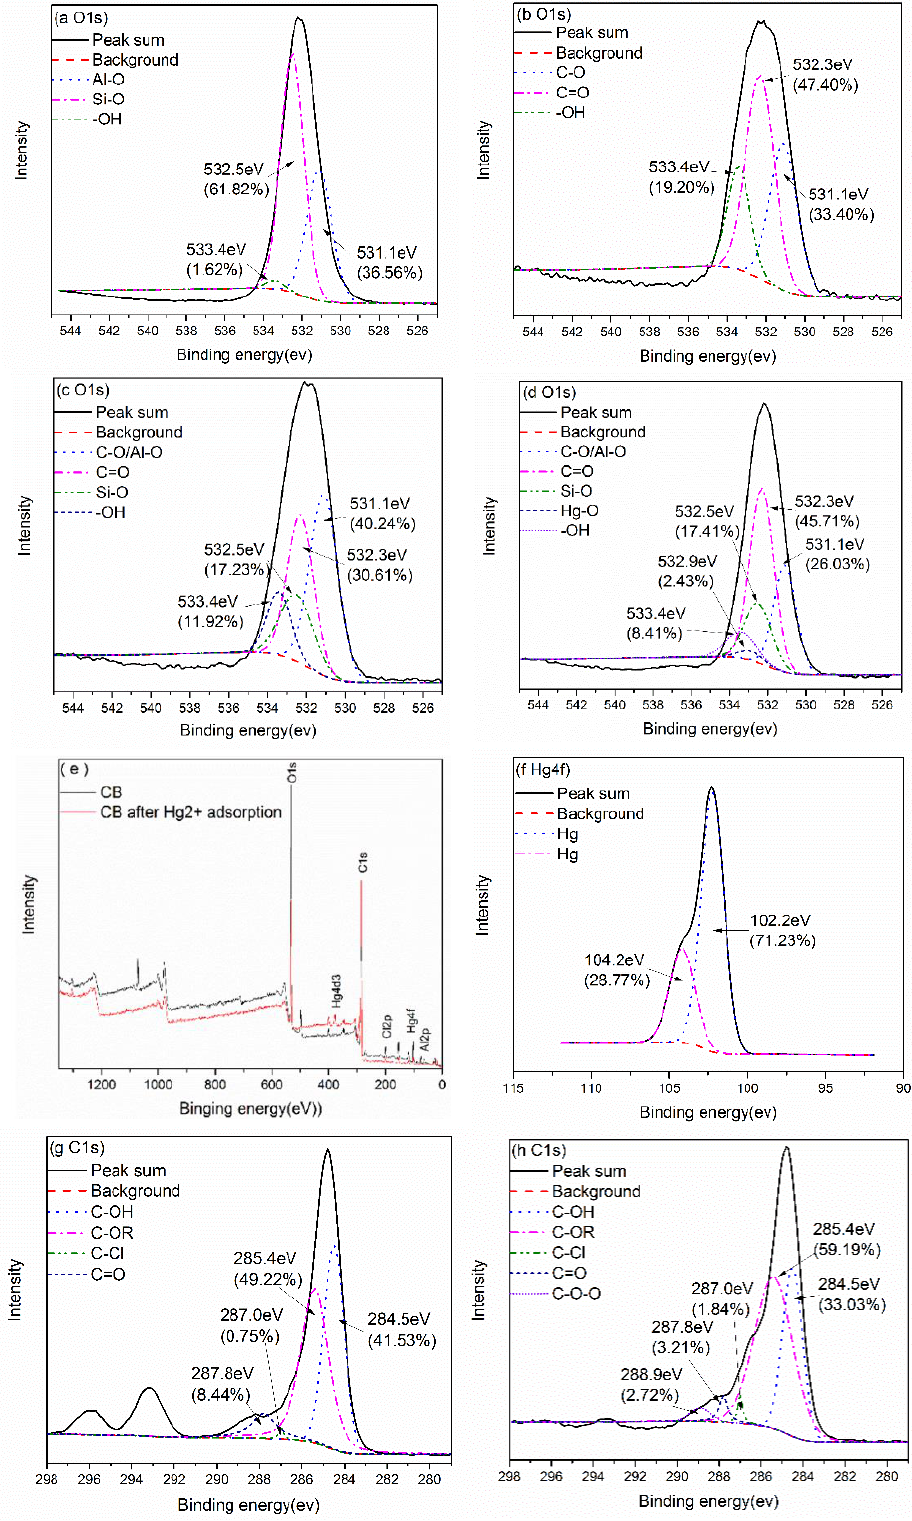
Figure 2. The XPS showing O1s core level in BE ( a ); XPS showing O1s core level in MB ( b ); XPS showing O1s core level in CB ( c ); XPS showing O1s core level in CB after Hg 2+ adsorption ( d ); XPS full survey of CB before and after Hg 2+ adsorption ( e ); XPS showing Hg4f core level in CB after Hg 2+ adsorption ( f ); XPS showing C1s core level in CB ( g ); XPS showing C1s core level in CB after Hg 2+ adsorption ( h ).